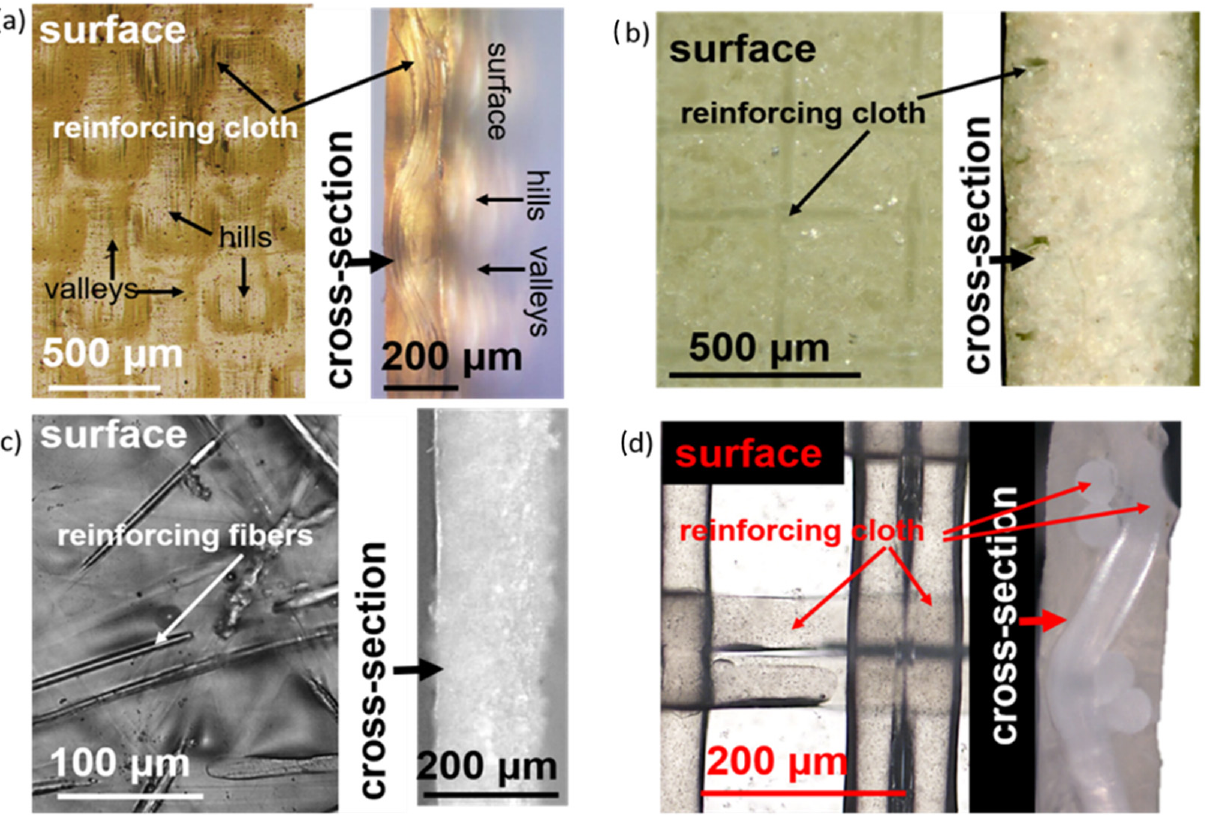
Figure 3. Optical images of the surface and cross-sections of pristine membranes CSE-fg ( a ), MK-40 ( b ), CEM Type-II ( c ), and CJMC-5 ( d ) in a 1.0 M NaCl solution.